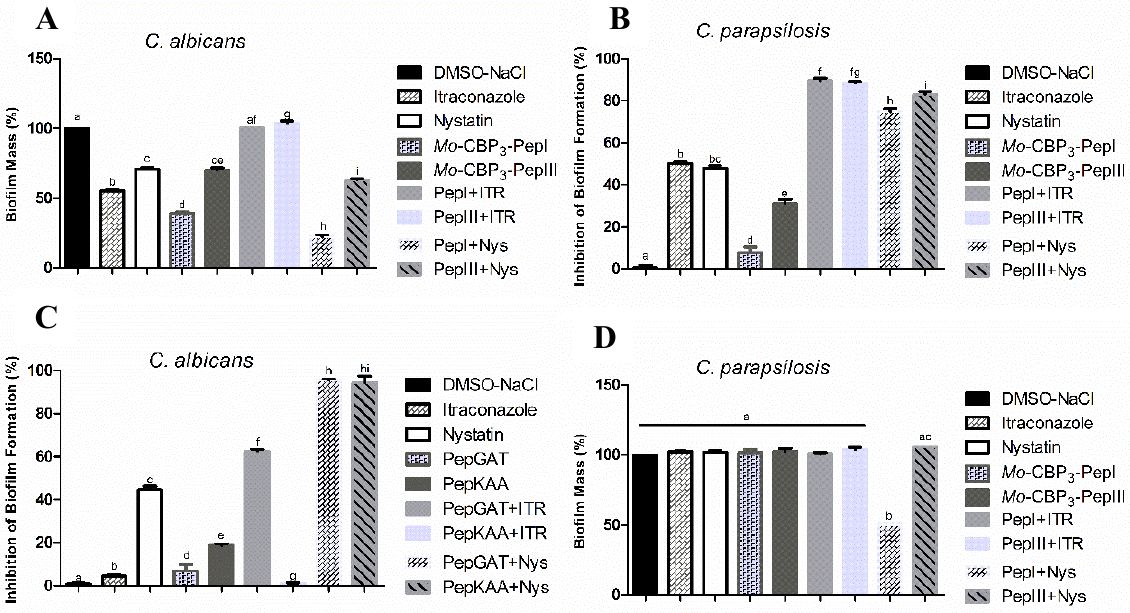
Figure 1. ( A , B ) Inhibitory activity of biofilm formation and ( C , D ) degradation of mature biofilm of C. albicans and C. parapsilosis . DMSO-NaCl was used as a negative control and ITR and NYS as positive controls. The letters represent the mean ± standard deviation of three replicates. Different lowercase letters indicate a statistically significant difference compared to DMSO-NaCl by analysis of variance ( p < 0.05).